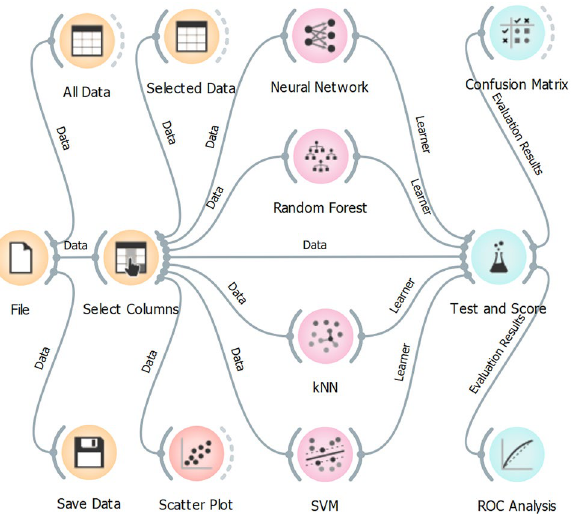
Figure 3. The graph structure of the Orange software implementing the selected detection algorithms (Neural Network, Random Forest Data, kNN, SVM) and compared by using stratified cross-validation method ( Test and Score ) by 5-folds. The results are presented by receiver operating characteristic curve ( ROC Analysis ) and an error matrix ( Confusion Matrix